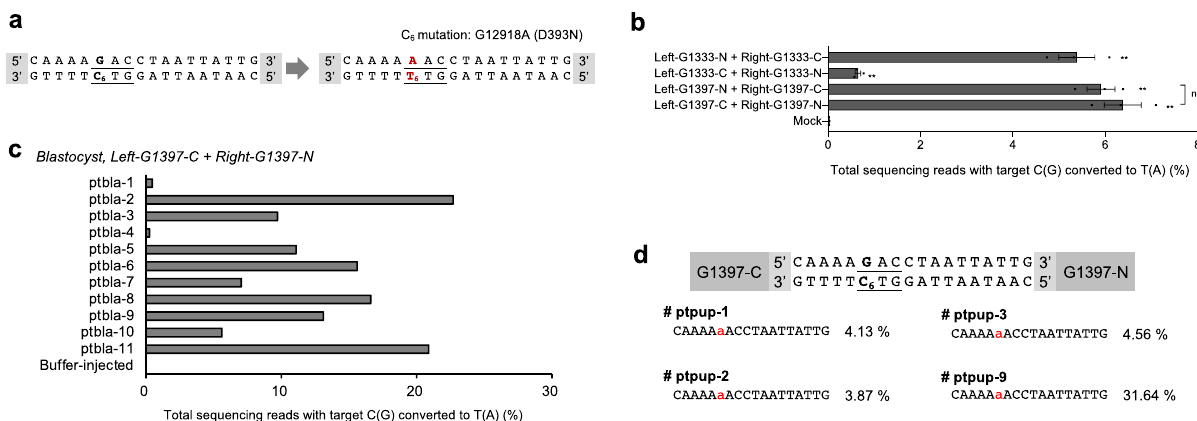
Fig. 4 Mouse mitochondrial ND5 G12918A mutation induced by DdCBE. a The DdCBE target for generating the m.G12918A point mutation, which would create a D393N change in the ND5 protein. The target codon is underlined and the possible editing locus is shown in red. b The ef fi ciency of cytosine-to-thymine base editing with DdCBE in NIH3T3 cells. The annotations indicate the combination of DdCBE pairs that were co-transfected. Error bars are s.e.m. for n = 3 biologically independent samples (n.s. not signi fi cant, * p <0.05, and ** p <0.01 using Student ’ s two-tailed t test). P values of left-G1333-N + right-G1333-C, left- G1333-C + right-G1333-N, left-G1397-N + right-G1397-C, and left-G1397-C + right-G1397-N for C 6 mutation are 0.0052, 0.0099, 0.0027, and 0.0040, respectively. P values for n.s. is 0.4971. c m.G12918A point mutation base editing ef fi ciency in mouse blastocysts. The sequencing data were obtained from cultured blastocysts that developed after one-cell stage embryos were microinjected with mRNA encoding the left-G1397-C and right-G1397-N DdCBE. d Mice (F 0 ) carrying an ND5 point mutation. F 0 pups, which harbor an ND5 point mutation, that developed after microinjection of the DdCBE mRNAs. Corresponding alignment of mutant sequences from newborn pups. Edited bases are shown in red, and the column on the right indicates the editing frequencies in the mutant mitochondrial genome. Source data are provided in the Source data fi